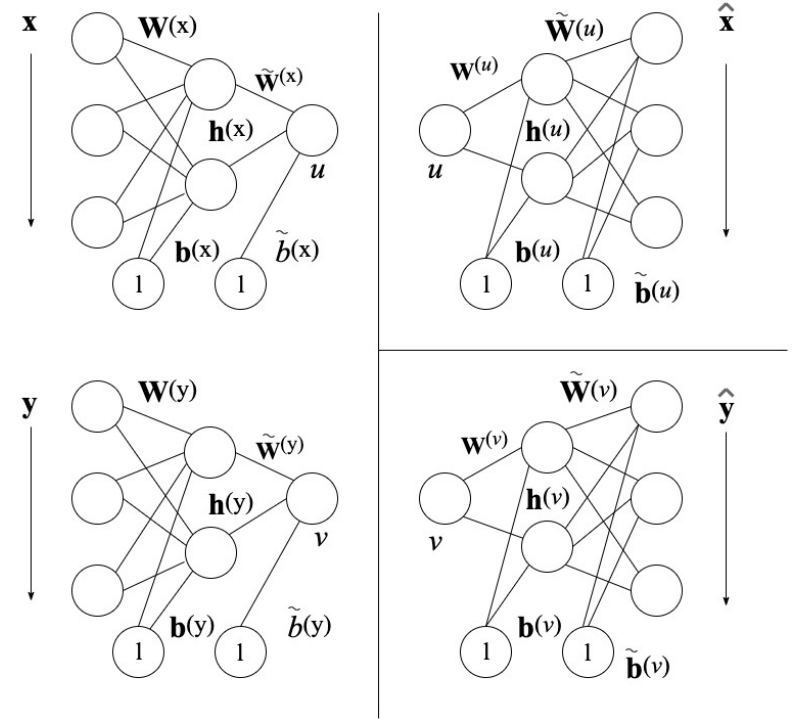
Figure 4. Neural Network Architecture for NLCCA